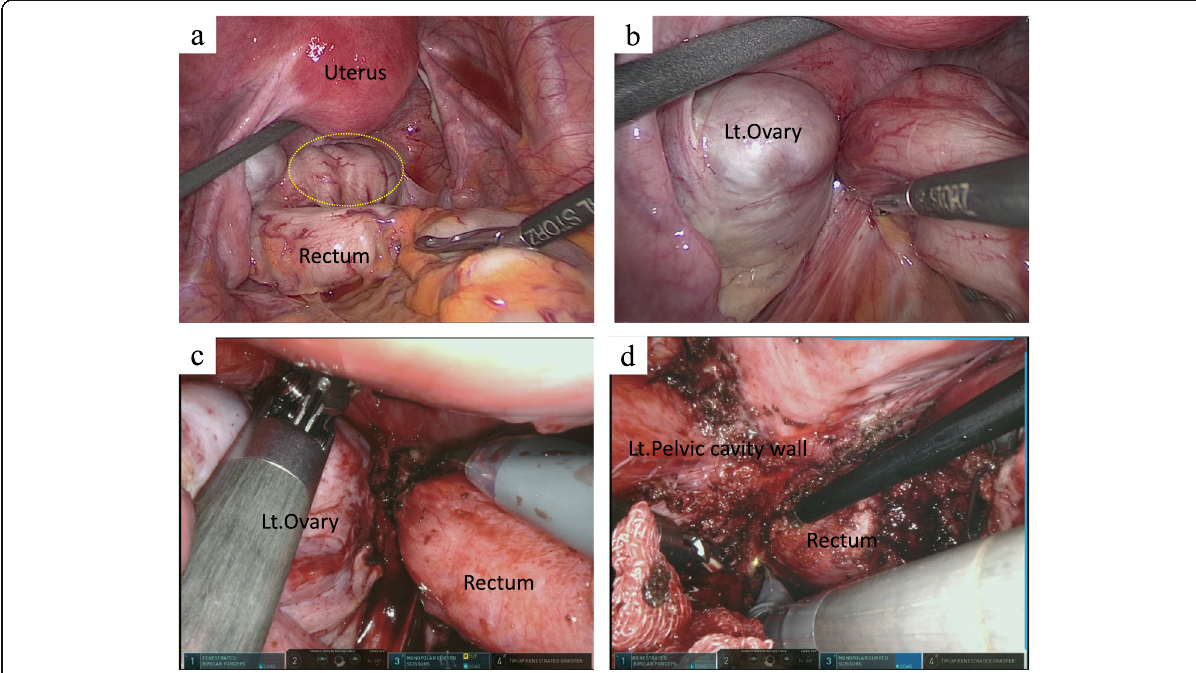
Fig. 3 Surgical imaging. a , b An adhesion was present between the left ovary cyst and rectum. There was no evidence of endometrium tissue. c , d The adhesion was removed by robot-assisted